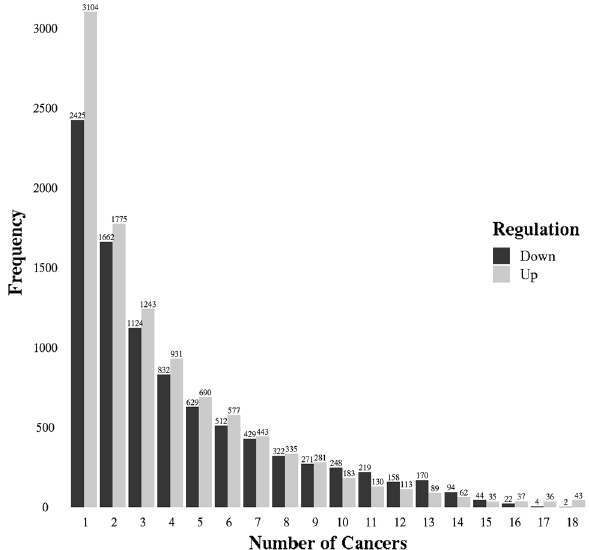
Figure 1. Bar plot representing the frequency of the differentially expressed genes against number of cancers. There are many genes which appear as differentially regulated in one or a few cancer types. However, comparatively smaller set of genes are differentially regulated in many cancer